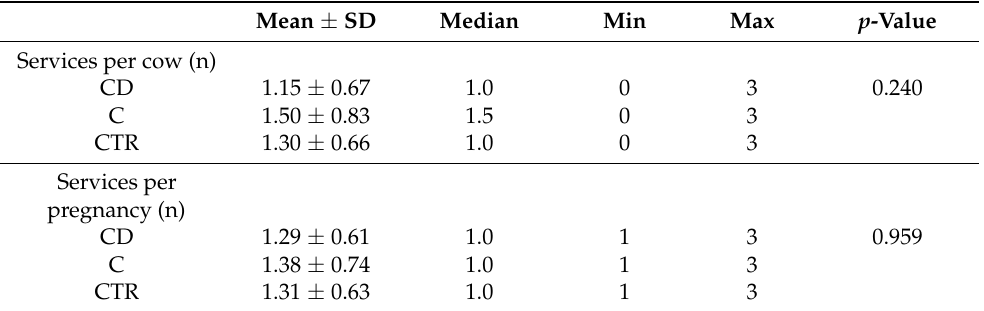
Table 1. Descriptive statistics of the number of services per cow and per pregnancy within 120 days in milk in the three treatment groups of 20 cows each (CD = ceftiofur + ketoprofen; C = ceftiofur; CRT = control). Results from the Kruskal–Wallis test are reported too.